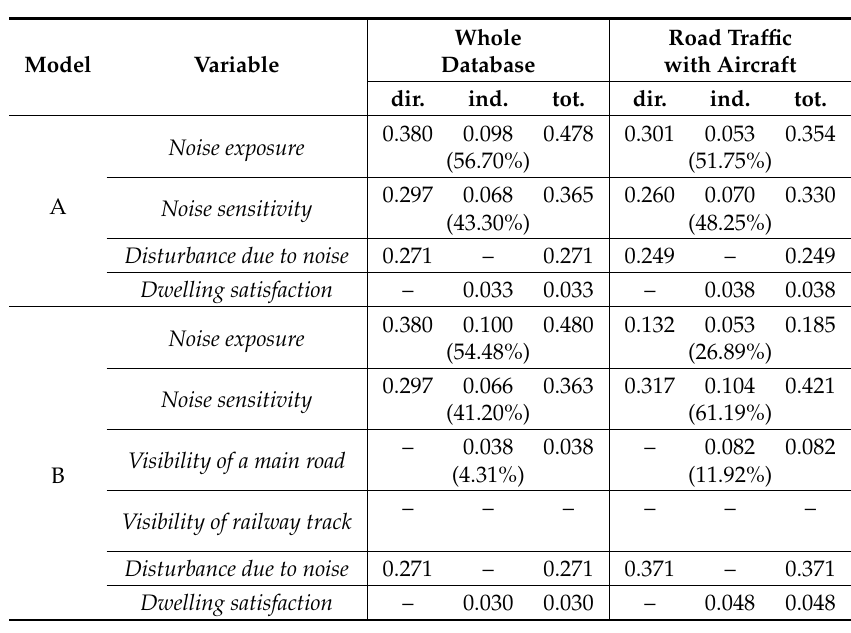
Table 6. Direct (dir.), indirect (ind.) and total (tot.) effects of all variables affecting noise annoyance due to aircraft noise in Models A and B. Contributions of exogenous variables are given in percentage between